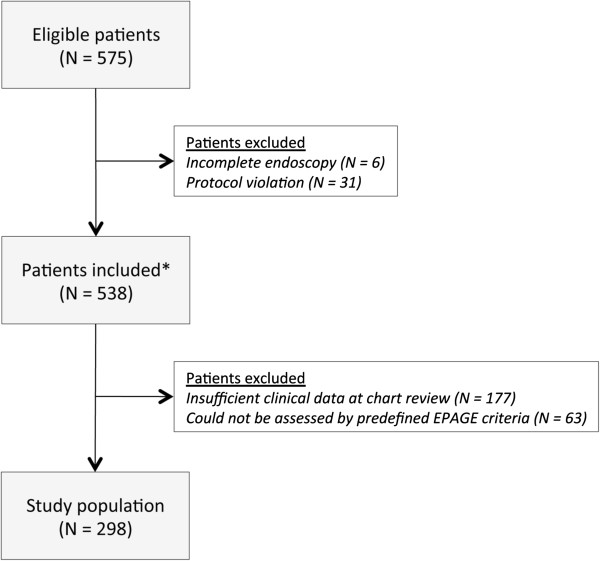
Study flow. Study flow of patients referred for endoscopy. A total of 277 patients were excluded: 6 patients because of incomplete endoscopy, 31 patients because of protocol violation (no follow-up investigation in normal endoscopy but faecal calprotectin > 50 μg/g), 244 patients because of insufficient data at chart review to calculate EPAGE score and 63 patients because they could not be assessed using the predefined list of EPAGE criteria. * Patients included in
[22].